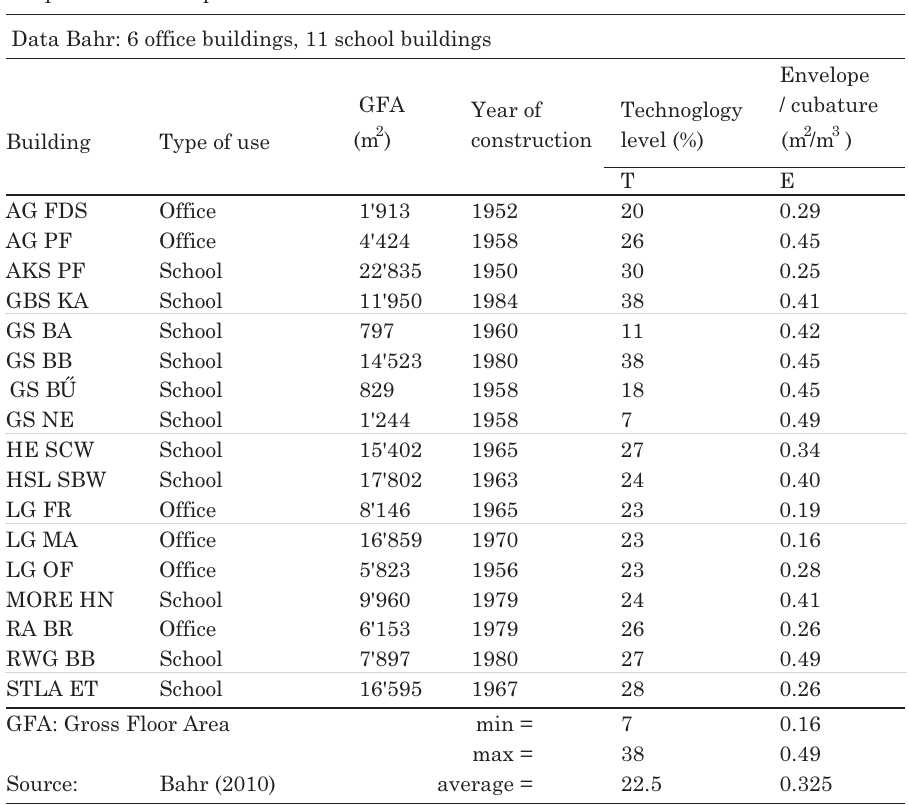
Table of the 17 buildings simulated in Stratus Scope of work: Comparison of methods Stratus /